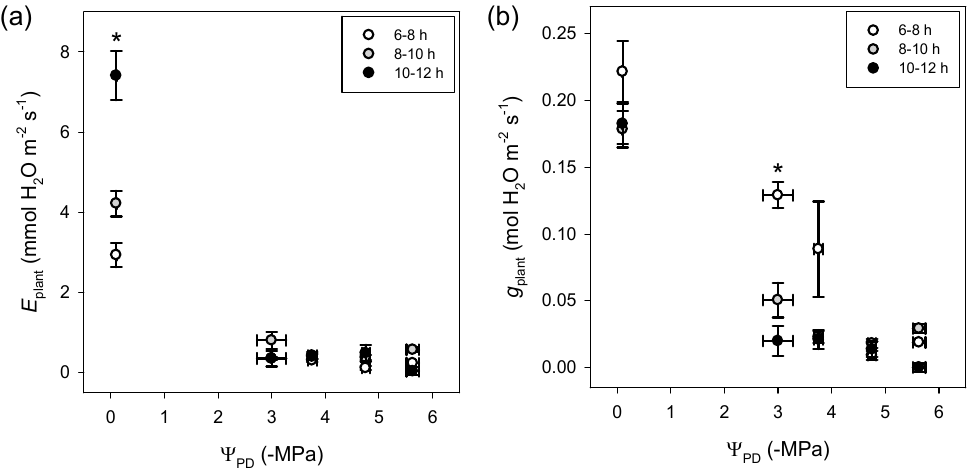
Figure 1. Time course of ( a ) whole-plant transpiration ( E plant ) and ( b ) whole-plant conductance ( g plant ) with predawn water potential ( ψ PD ) for holm oak leaves during the drought period at early morning (between 6 and 8 h solar time, white symbols), mid-morning (between 8 and 10 h solar time, grey symbols) and midday (between 10 and 12 h solar time, black symbols). Data are mean ± SE. Asterisks indicate significant differences among early morning, mid-morning and midday for each level of ψ PD (Tukey’s test, p < 0.05).